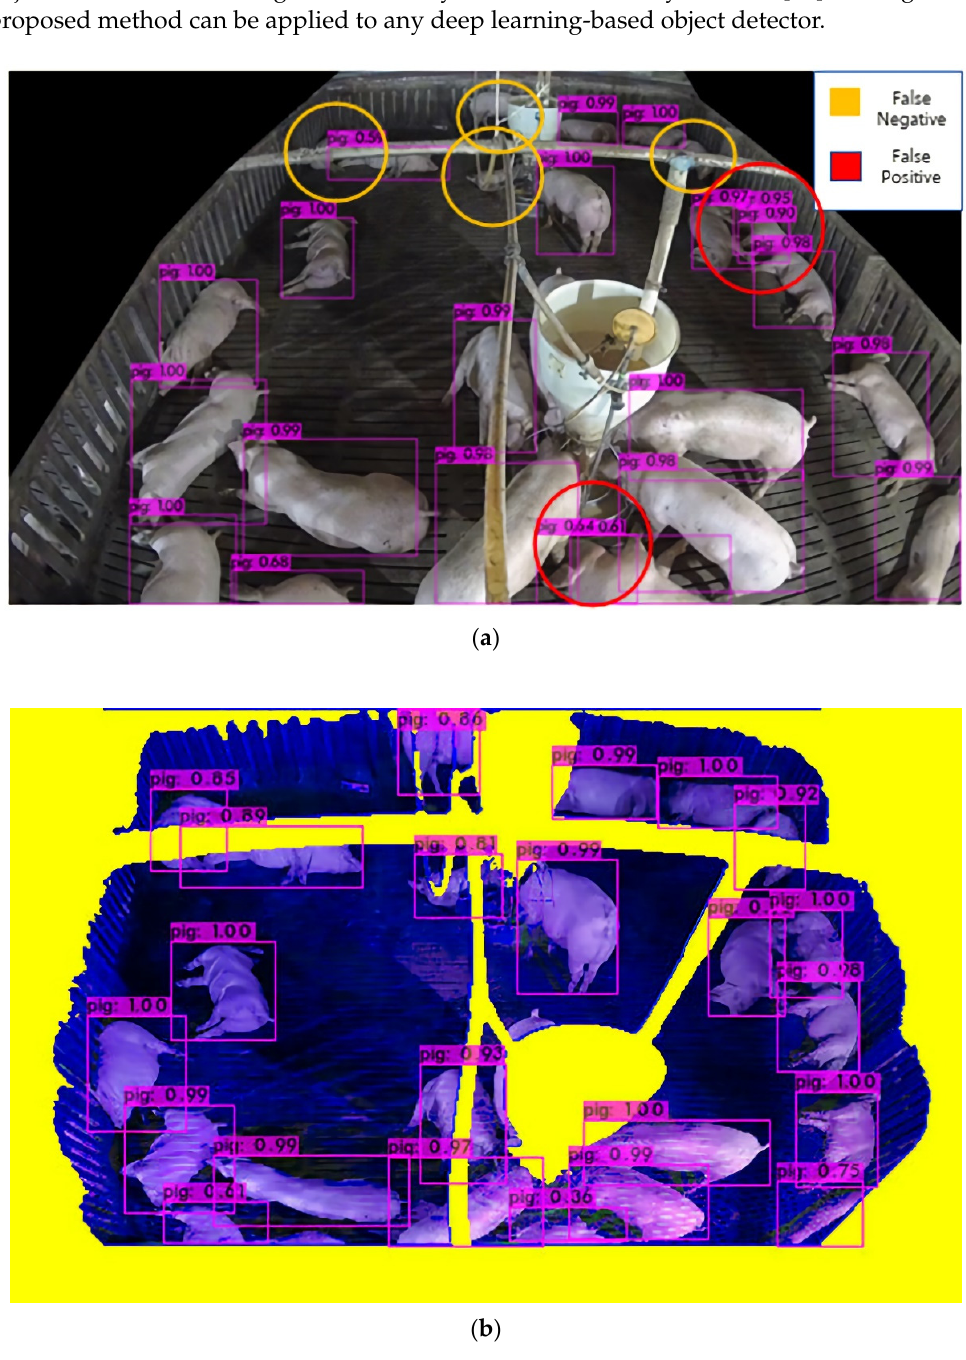
Figure 1. The pig detection results for a commercial pig pen with a tilted-view static camera.